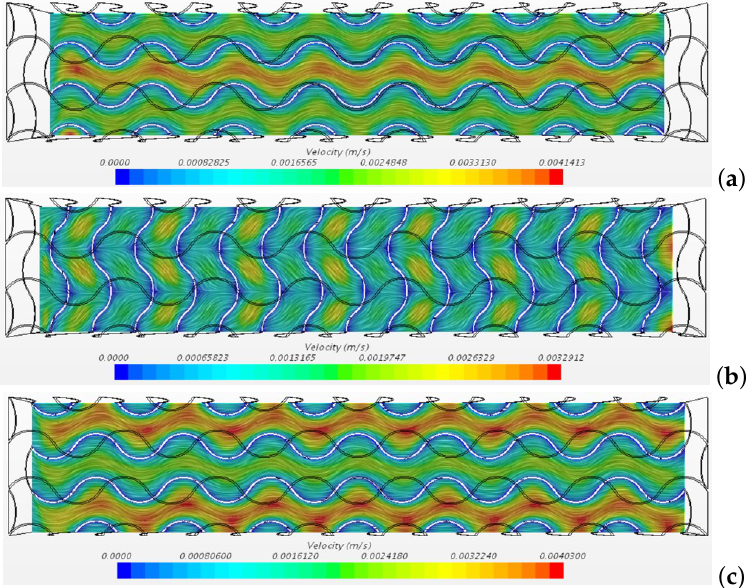
Figure 6. Streamlines for the case Re = 3.6 on three planes z / W = 1/3 ( a ) z / W = 1/2 ( b ) and z / W = 2/3 ( c